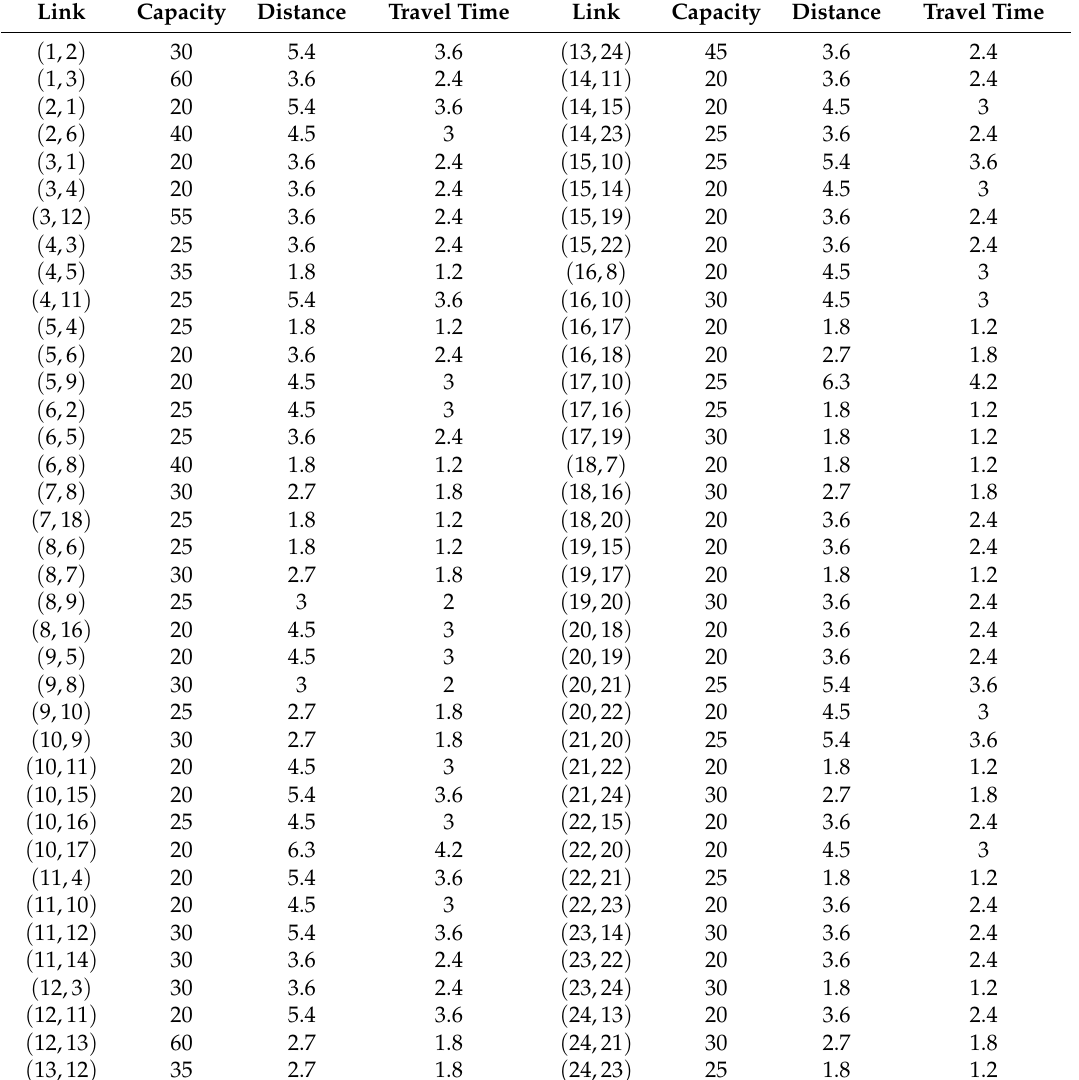
Table 15. Sioux Falls network information (link capacity (veh/h), distance (mi), travel time (min)).